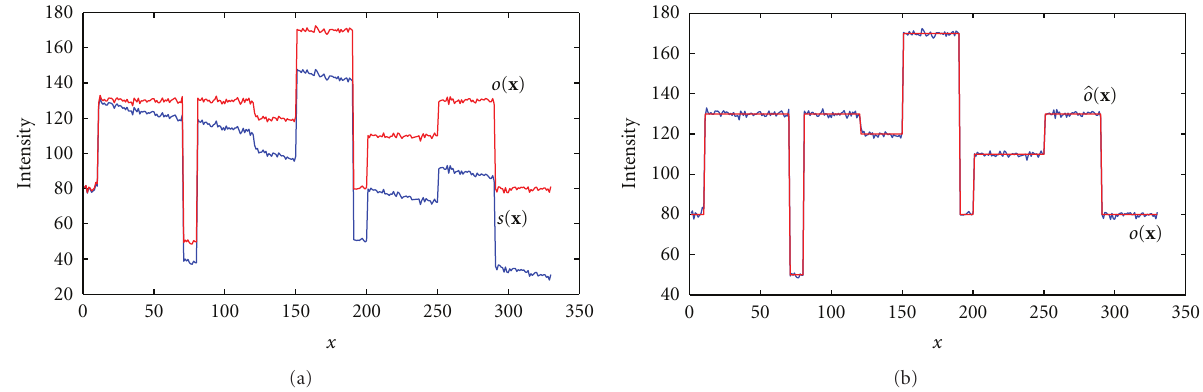
Figure 2: (a): Example of a line of input signal: o ( x ) is the ideal signal with the texture noise, s ( x ) is acquired signal furthermore corrupted by non-homogenous illumination (b): results of the correction process, o ( x )—ideal signal, (cid:6) o ( x )— signal after entropy-based correction (nearly ideally